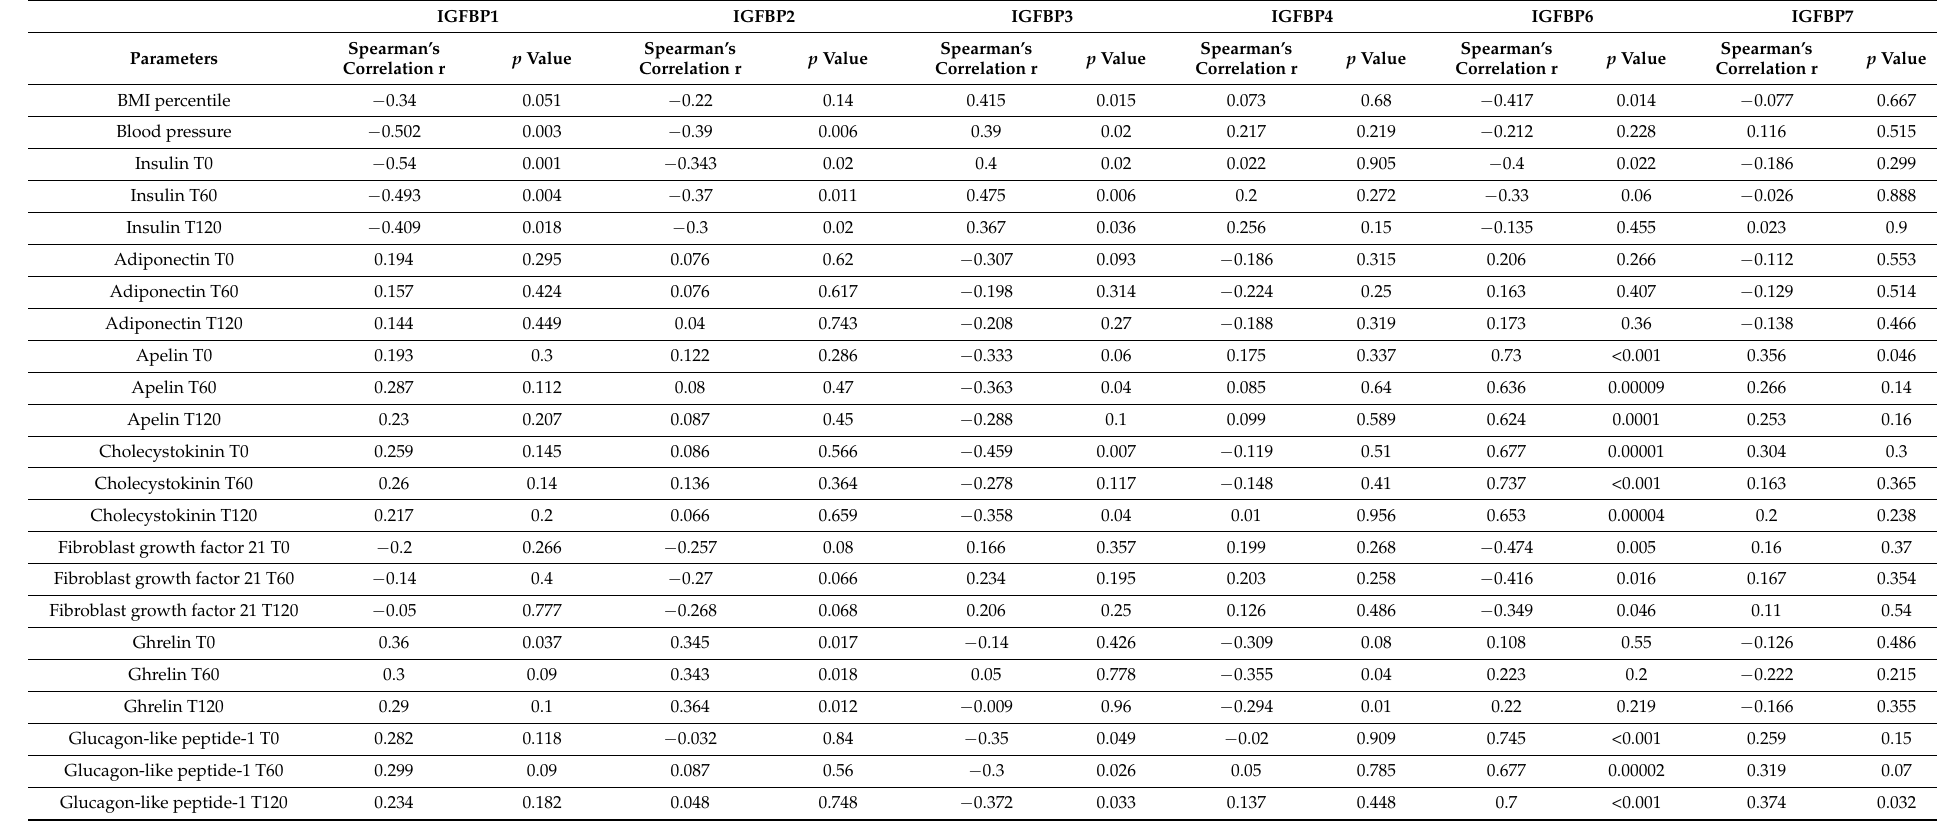
Table 5. Correlation results of IGFBPs’ concentrations with selected metabolic parameters. T0—measured at fasting; T60—measured at 60 min and T-120—measured at 120 min of the standard oral glucose tolerance test